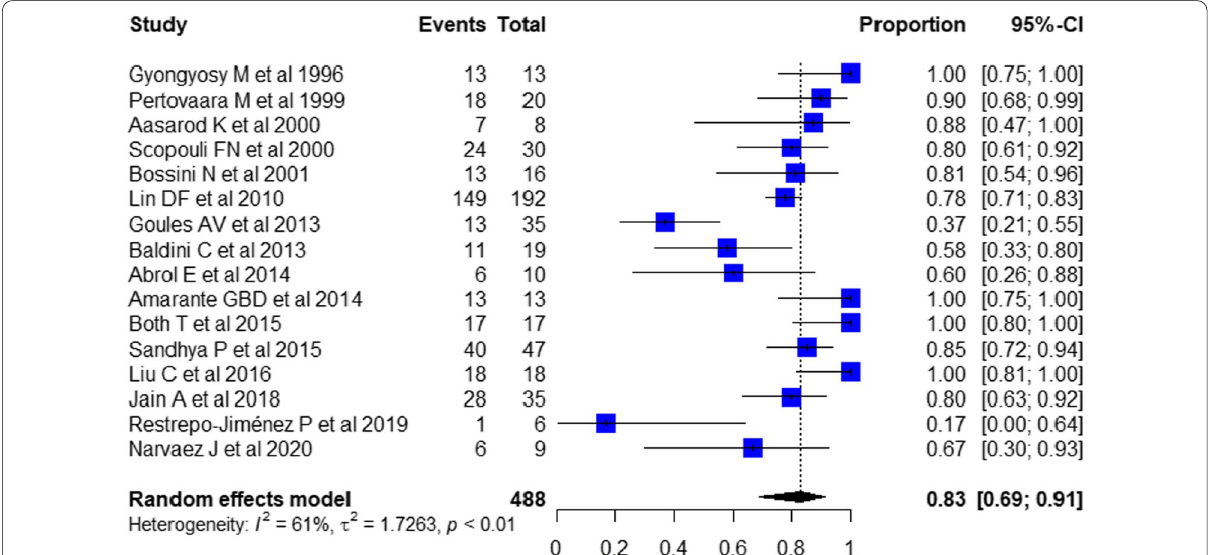
Fig. 13 Meta‑analysis of the Tubulointerstitial Nephritis in patients with Sjogren’s